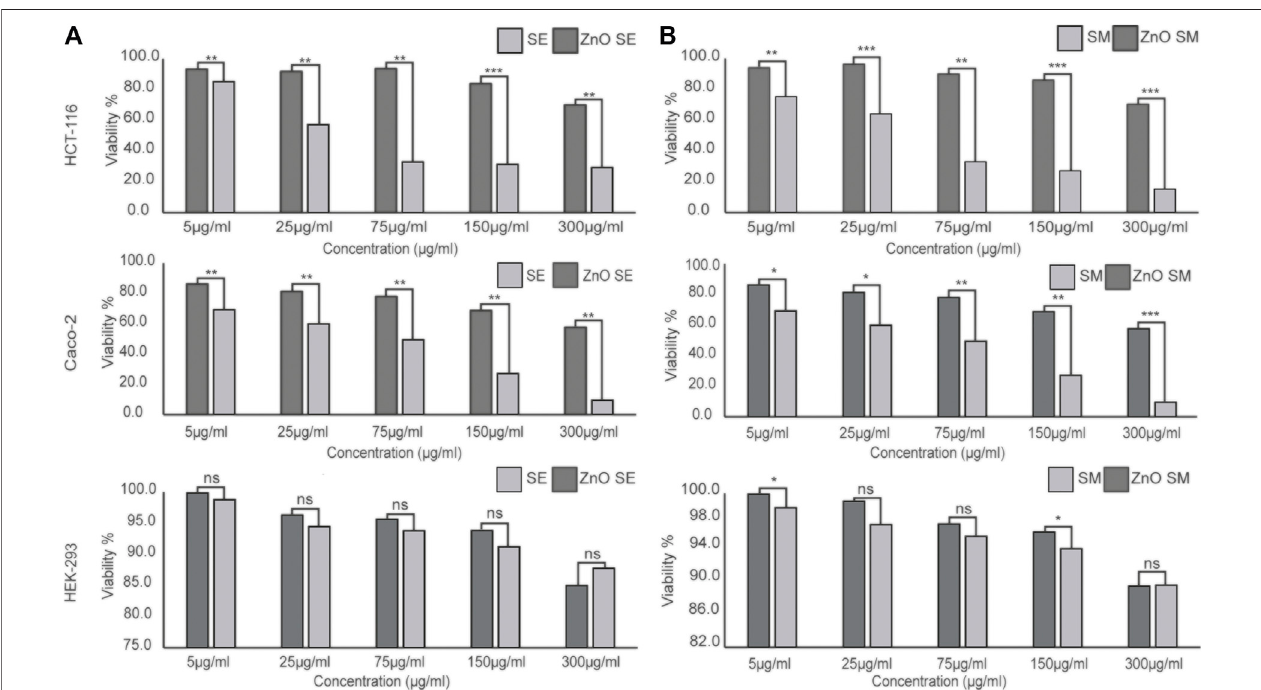
FIGURE7| Invitrocytotoxicef fi cacyofcrudeextract and greenZnO-NPs synthesizedfrom ethanol (A) and methanol extracts (B) of S. chirayita leaves. Colorectal cancer (CRC) cells (HCT-116 and Caco-2) and control cells (HEK-293) were treated with SE, SM, ZnO SE, and ZnO SM. The results are expressed as cell viability percentage(%)incomparisonbetweentreatmentsofcrudeextractandcorrespondingZnO-NPsconjugatedwiththephyto-constituentsoftheplant.Thedatarepresent themeanvalues ± SDofthreeindependentexperimentsperformedintriplicate.StatisticalvalueswerecalculatedusingANOVA:singlefactor.* p ≤ 0.05,** p ≤ 0.01, *** p ≤ 0.001, nsP > 0.05. SE, ethanol extract of S. chirayita leaves; SM, methanol extract of S. chirayita leaves; ZnO SE, biogenic ZnO-NPs conjugated with ethanol extract of S. chirayita leaves; ZnO SM, biogenic ZnO-NPs conjugated with methanol extract of S. chirayita